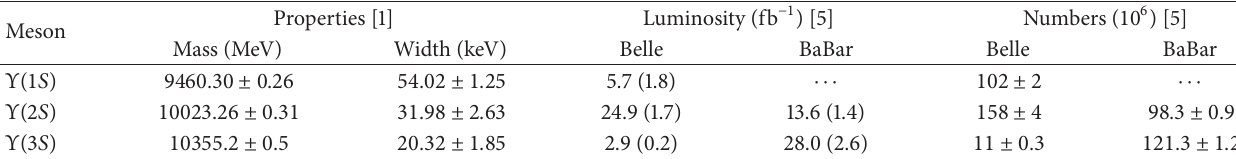
Table 1: Summary of mass, decay width, on(off)-peak luminosity, and numbers of Υ(𝑛𝑆) .